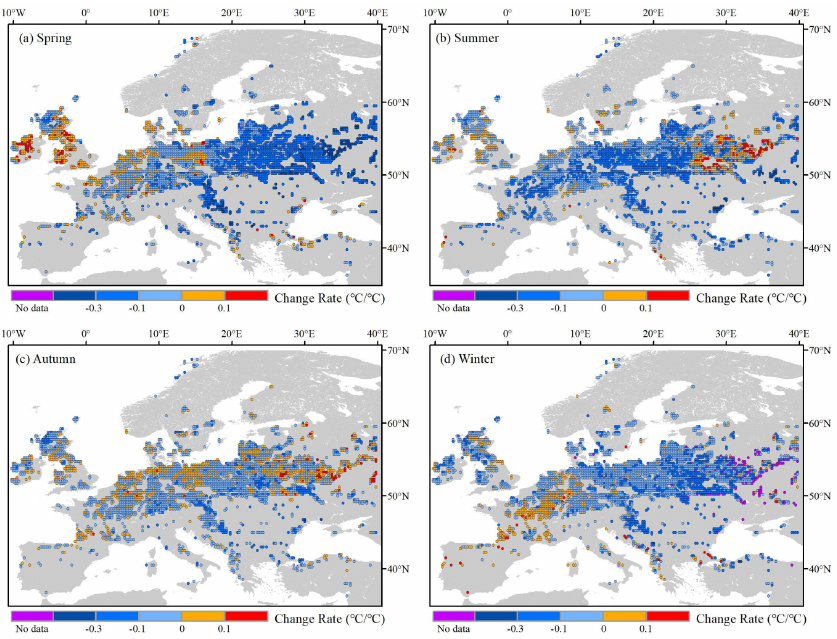
Figure 8. The relationship between background LST and daily LST differences (forest minus open land) in ( a ) spring, ( b ) summer, ( c ) autumn, and ( d ) winter during various years. Spring, summer, autumn and winter are defined by March and May, June and August, September and November, and December and February, respectively. The significance map of the four seasons is similar to Figure 7b and is not shown